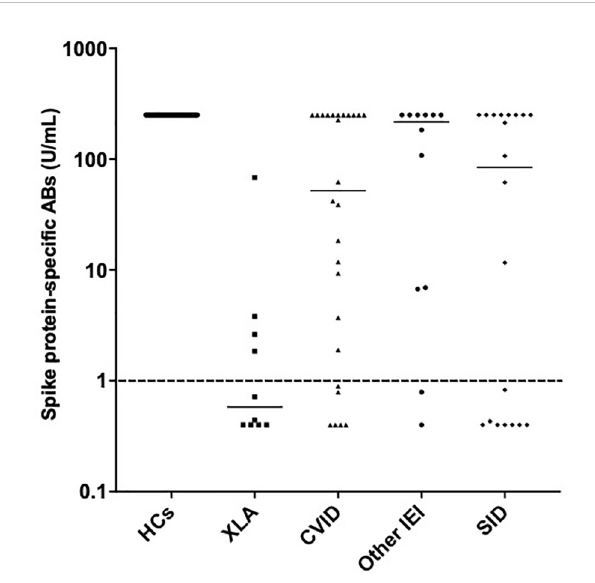
FIGURE 4 Spike protein-speci fi c antibody responses post primary vaccination in healthy controls, individuals with X-linked agammaglobulinemia, common variable immunode fi ciency, other inborn errors of immunity and secondary immunode fi ciency. Individual values are plotted on a logarithmic scale (log